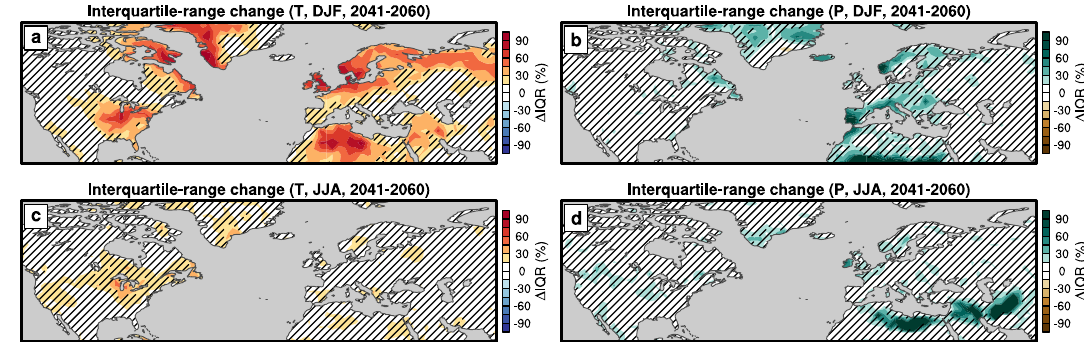
Fig. 3 Change in projection uncertainty for mid-century climate change. a The change in the 2041 – 2060 winter (DJF) surface-air temperature interquartile range in the MPI-GE-obs ensemble, with respect to the interquartile range in the MPI-GE-raw ensemble. b as in a but for the winter precipitation. c as in a but for the summer surface-air temperature. d as in a but for the summer precipitation. The black hatching indicates regions where the difference in the interquartile range between MPI-GE-obs and MPI-GE-raw is not statistically signi fi cant (at the 95% level, based on a Monte Carlo resampling, see ‘ Methods ’ for further details).